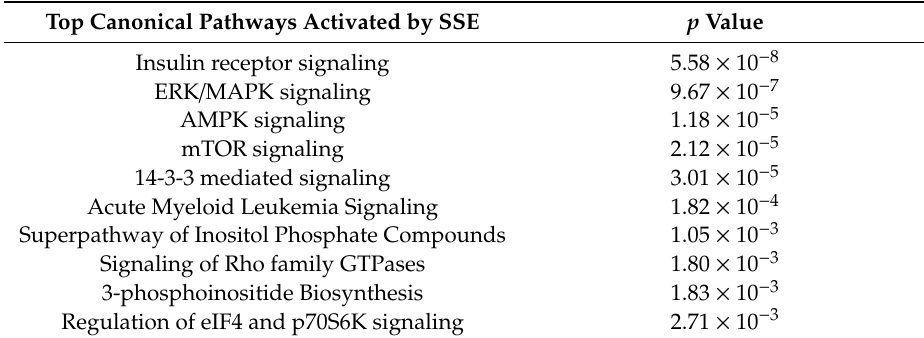
Table 1. Pathways significantly a ff ected by SSE in 3T3-L1 adipocytes.